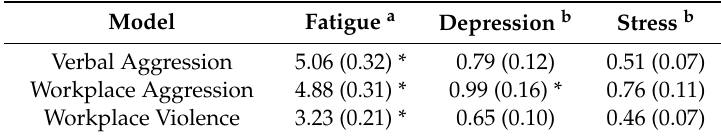
Table 3. Multivariable regressions predicting health outcomes of PSWs from di ff erent forms of workplace